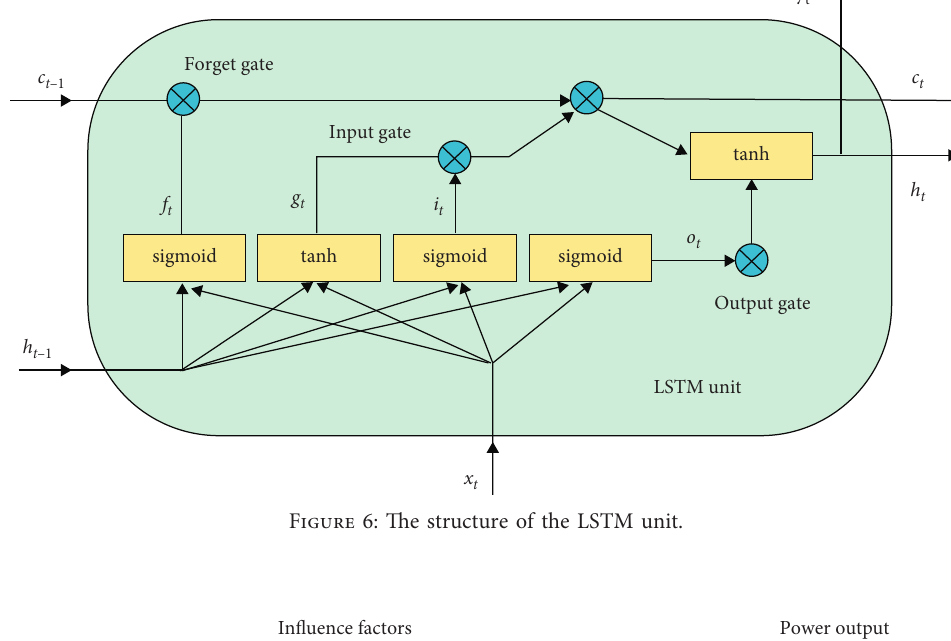
Figure 6: The structure of the LSTM unit.